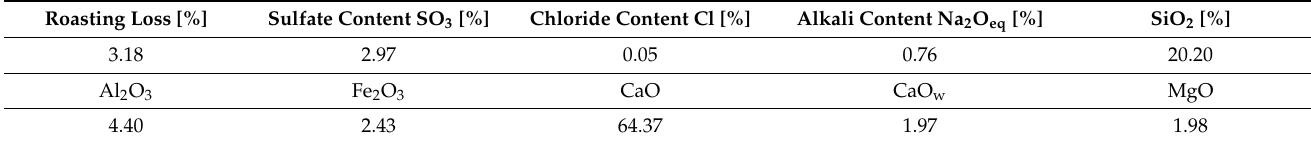
Table 2. Chemical properties of cement CEM I 42.5R.